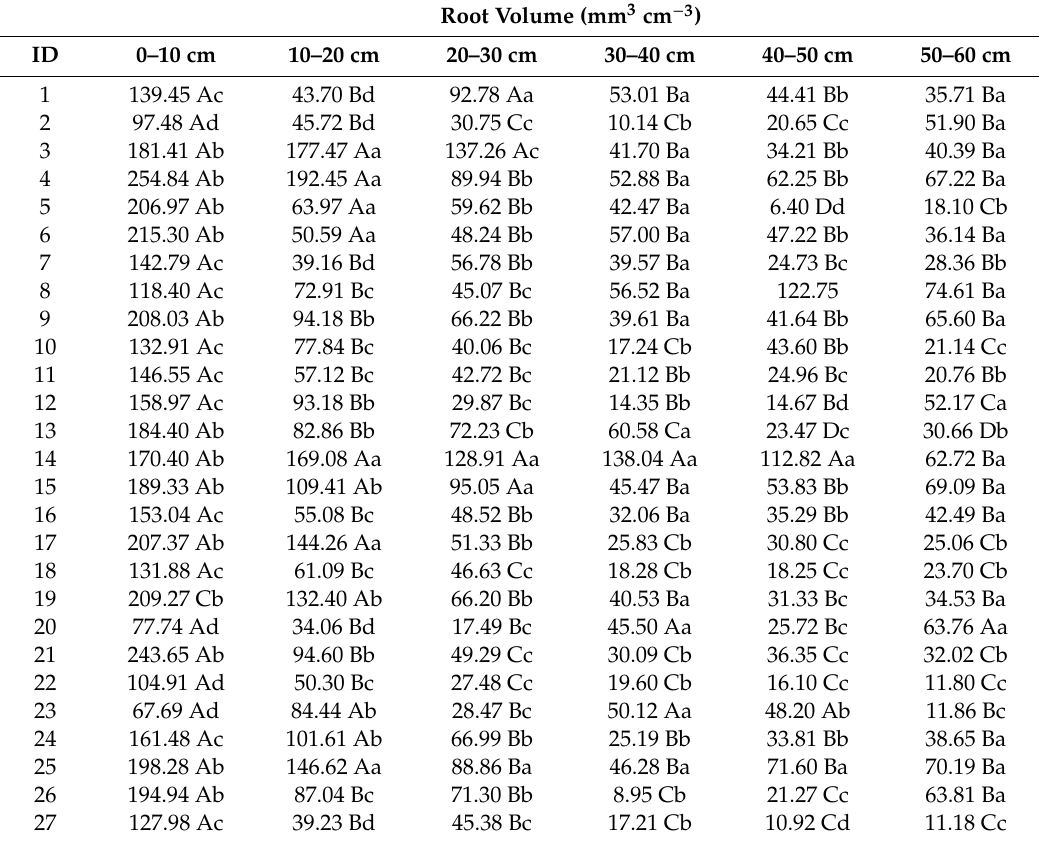
Table 4. Average root volume of 43 C. canephora genotypes in six soil